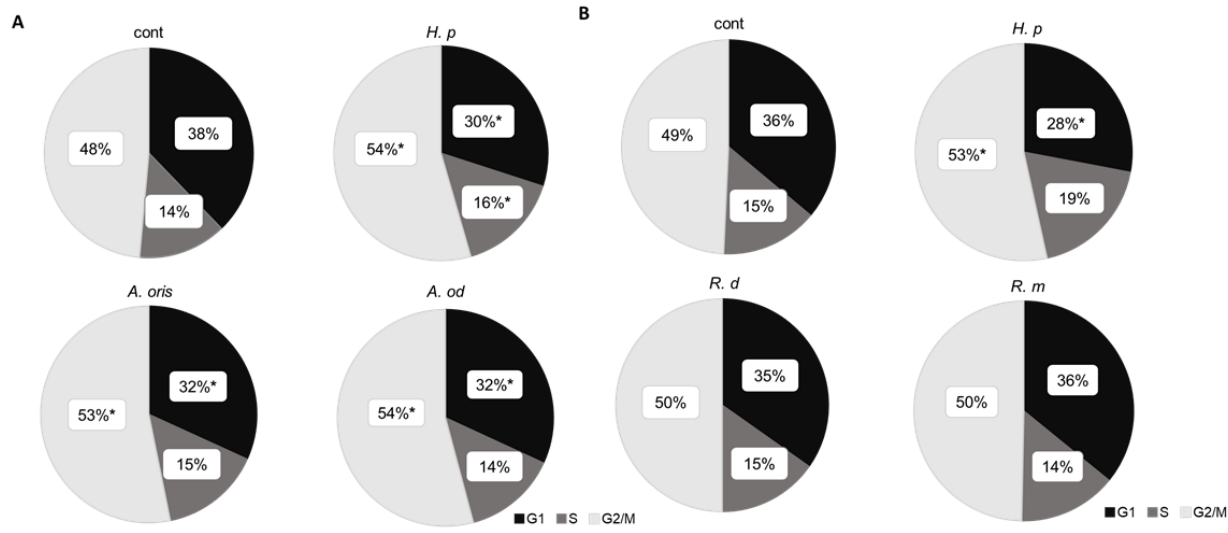
Figure 4. Cell cycle stimulated with bacterial supernatant. Gastric epithelial cells (AGS) were stimulated ( n = 3) with each strain, and cell cycle phases were analyzed using MACSQuant analyzer. (* p < 0.05 vs. control). ( A ) Stimulation with H. pylori or Actinomyces spp.; ( B ) stimulation with H. pylori or Rothia spp.